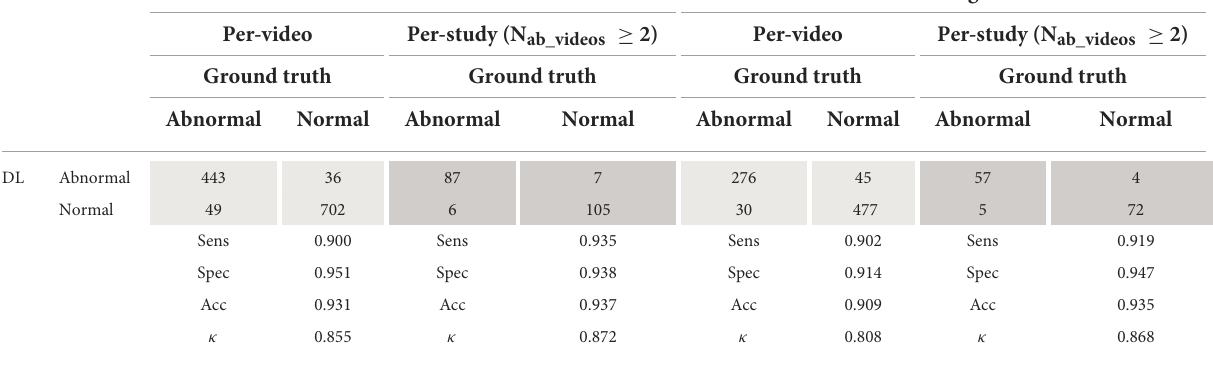
TABLE 1 DL classification performance in cross-validation and testing.